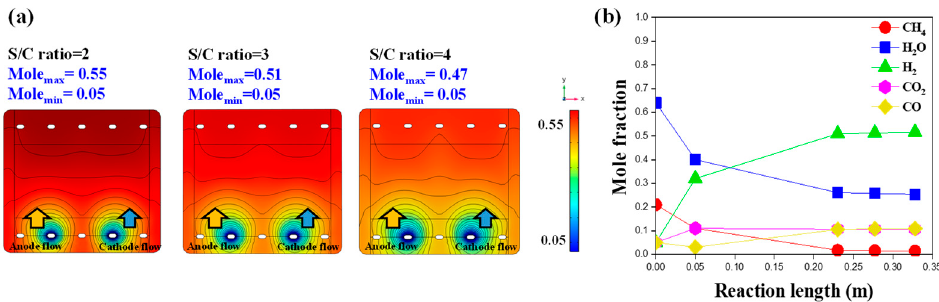
Figure 13. ( a ) Hydrogen distribution according to the S/C ratio and ( b ) chemical composition at the S/C ratio of 3 in the absence of an electrochemical reaction.